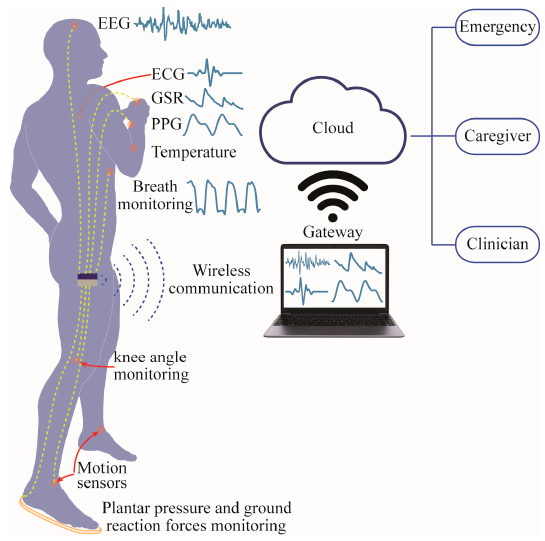
Figure 3. Schematic representation of a multisensory architecture for remote health monitoring.